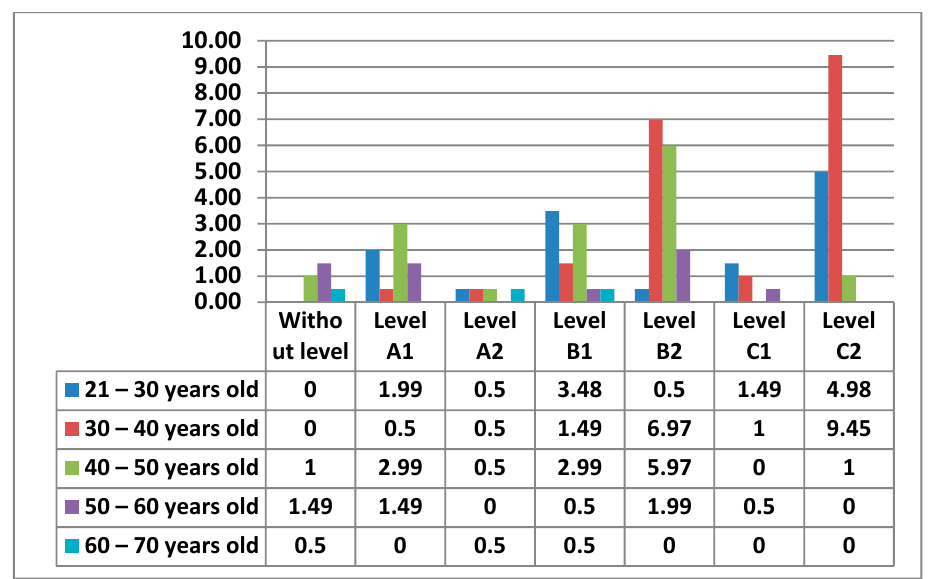
Figure 29. Digital competence in men by age in Area 5.